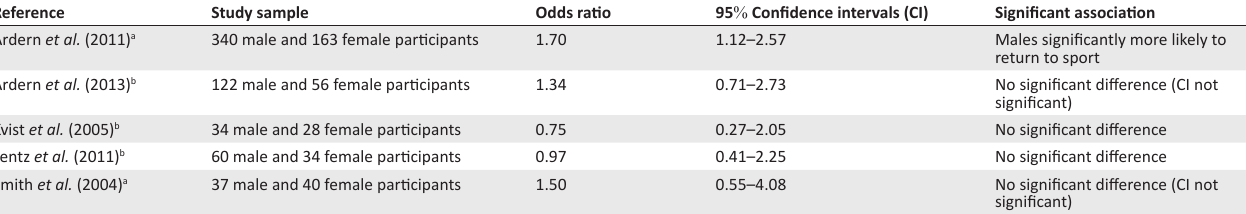
TABLE 4: Association of gender with return to sport.